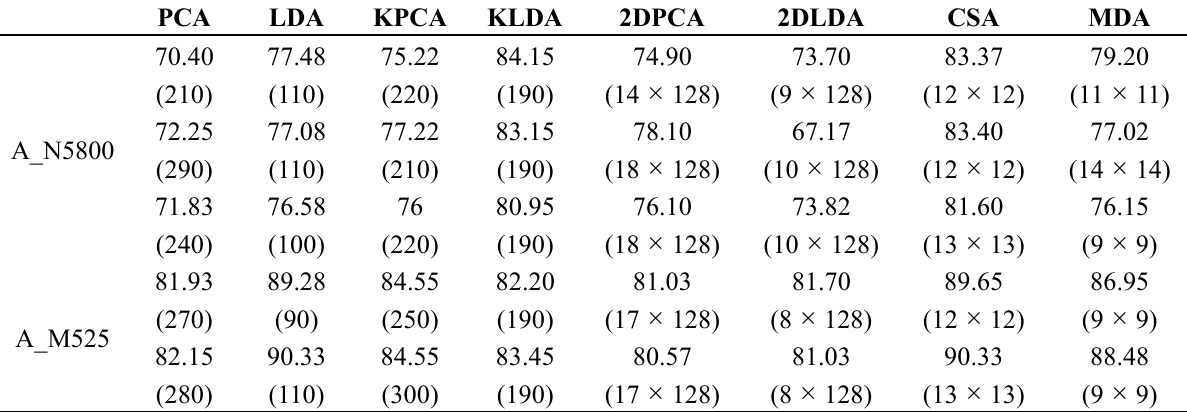
Table 4. BIRs (%) and corresponding dimensions (the number in the bracket) of different subspace learning methods conducted three times on three